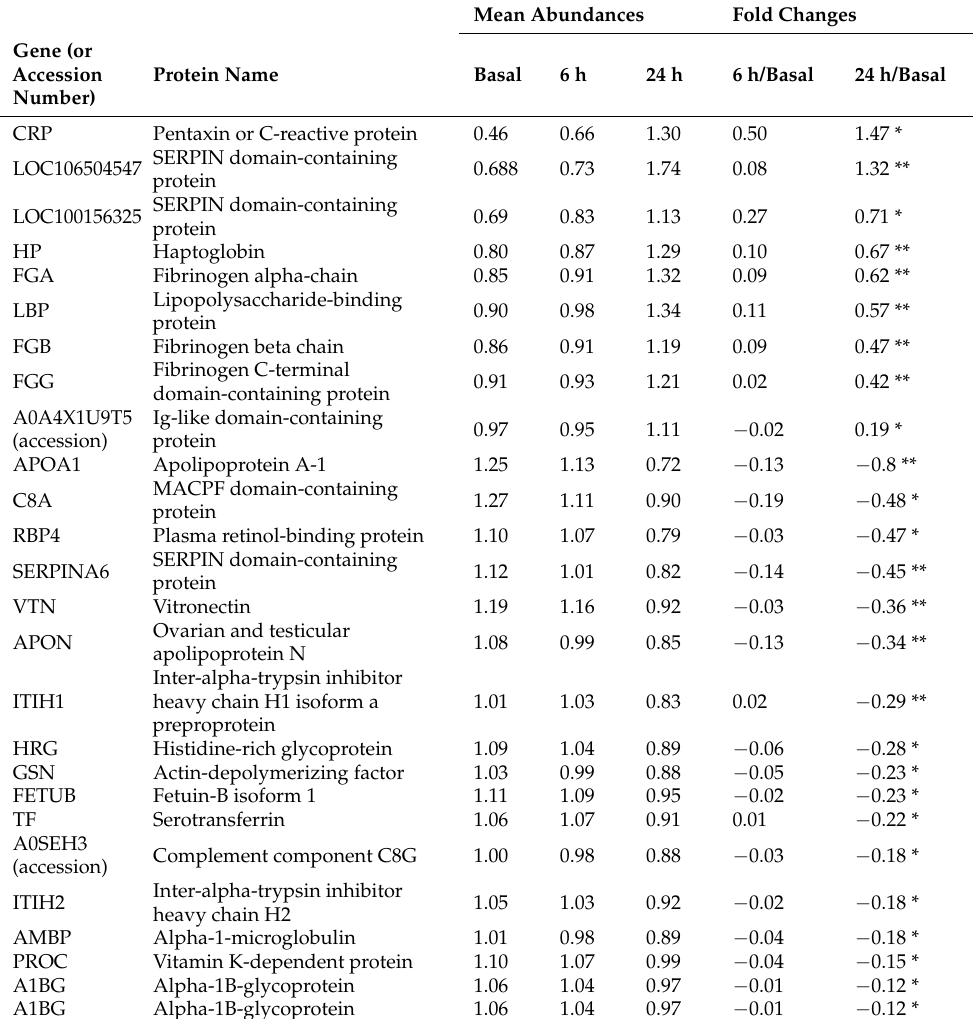
Table 4. Differentially expressed serum proteins in pigs with experimentally-induced non- septic